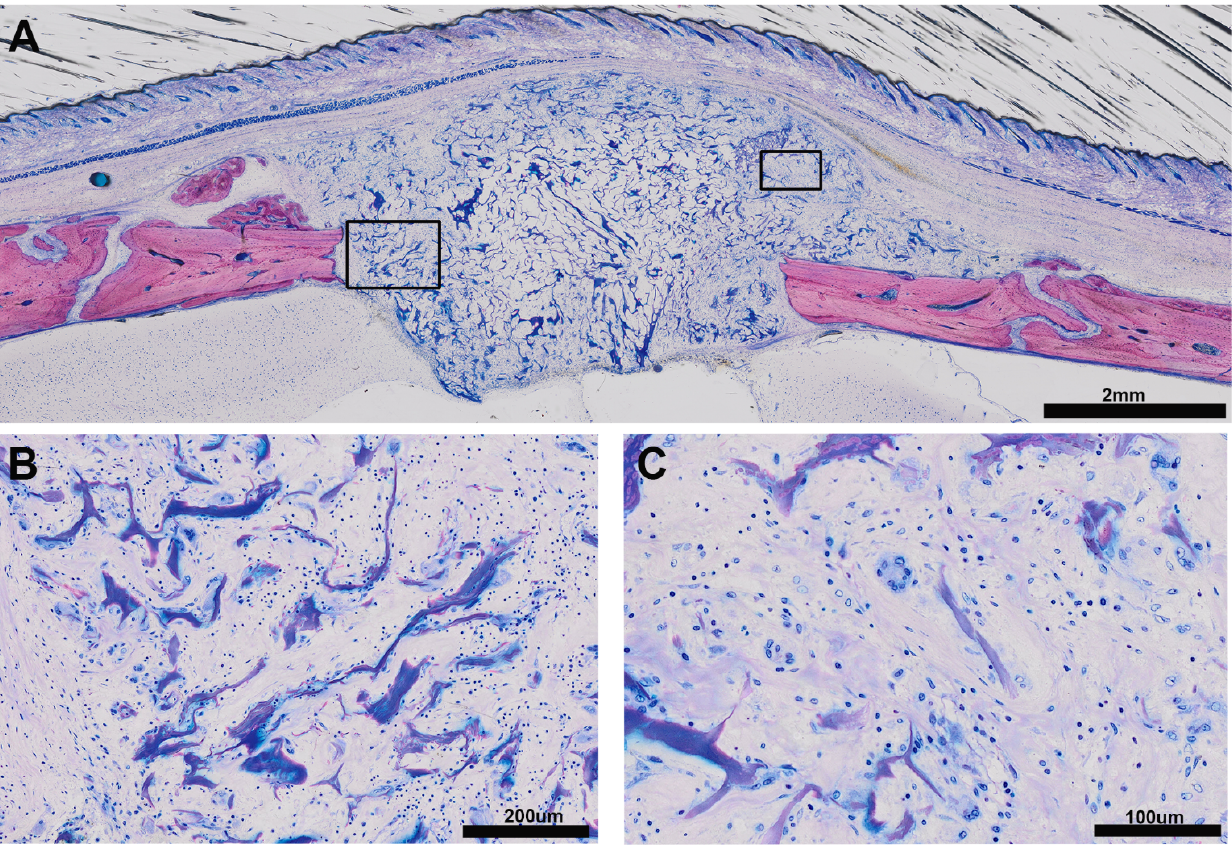
Figure 5. Insights into the VSCM show no mineralization. The specimen that shows no bone formation is depicted in the overview ( A ). The presence of inflammatory infiltrate surrounding the VSCM fibers is visible ( B ). A higher magnification view reveals occasionally multinucleated cells and light purple staining that indicated the presence of newly formed extracellular matrix produced by spindle-shaped fibroblastic cells ( C ).